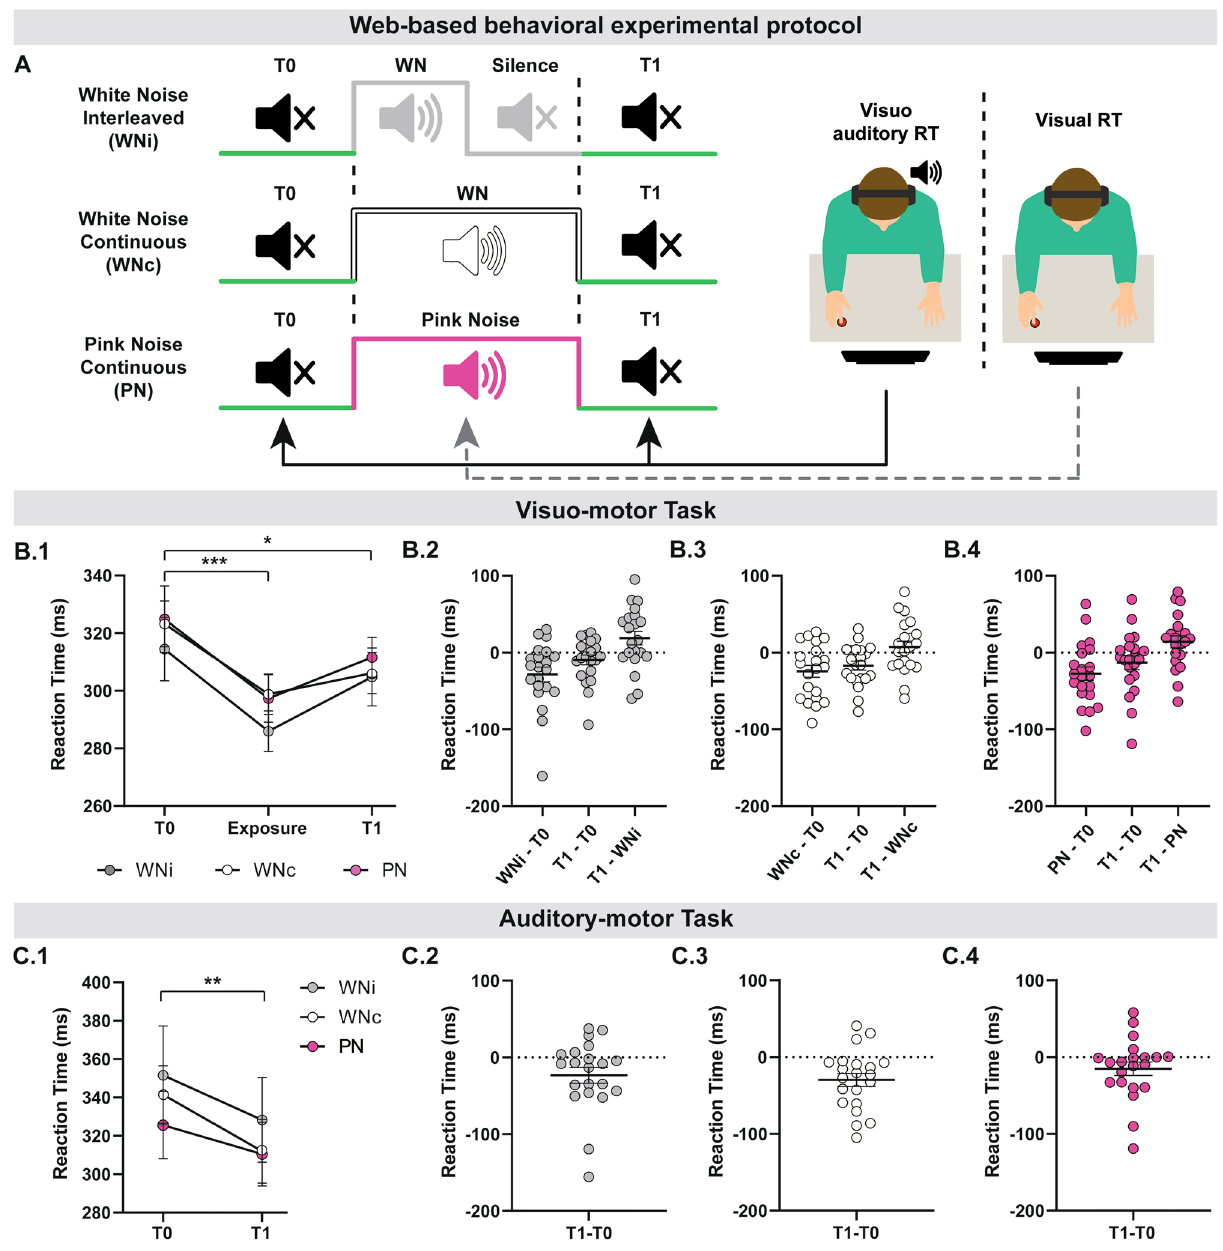
Figure 3. Web-based behavioural experiment. ( A ) Schematic representation of web-based behavioural task. This experiment was designed to assess WNi, (White Noise Interleaved), WNc (White Noise Continuous) and PN (Pink Noise) effects on complex sensory-motor integration. The order of conditions was randomized across subjects. Subjects were cued through two different sensory routes (visual, auditory) to press as quickly as possible a keyboard key with their right index finger. Visuo-motor RT was performed at T0, during auditory exposure and at T1. Auditory-motor RT was performed at T0 and T1. Subjects were at home, seated in front of their PC screen with earplugs/phones. Subjects were asked to fixate at a cross. The visual cue was a red circle; the acoustic cue was a pure sound. ( B ) Visuo-motor task. WNi, WNc and PN improved performance of visuo- motor task, both during and after exposure to auditory noise. ( B1 ) Mean ± SER performance across subjects, by condition (WNi, WNc, PN), before (T0), during (Exposure) and after (T1) exposure to auditory noise. ( B2 ) WNi intrasubject RT differences. ( B3 ) WNc intrasubject RT differences. ( B4 ) PN intrasubject RT differences. ( C ) Auditory-Motor task. WNi, WNc and PN improved performance of auditory-motor task. ( C1 ) Mean ± SER performance across subjects by condition (WNi, WNc, PN), before (T0) and after (T1) exposure to auditory noise; ( C2 ) WNi intrasubject RT difference; ( C3 ) WNc intrasubject RT difference; ( C4 ) PN intrasubject RT differences. Variability is expressed as standard error of the mean. *,** and *** denote p < 0.05, p < 0.001 and p < 0.001